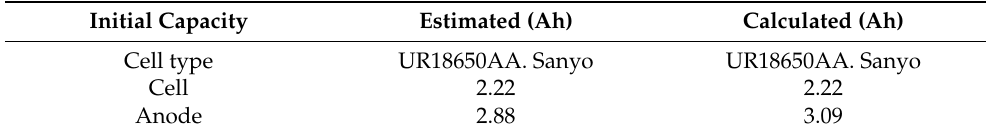
Table 3. Capacity comparison to the existing